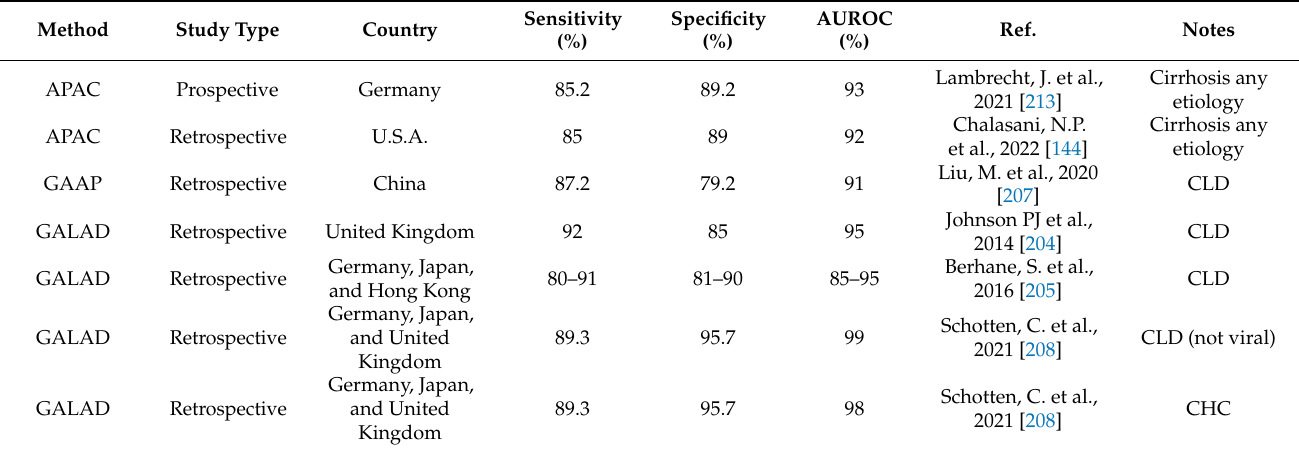
Table 3. Example of candidate HCC diagnostic/prognostic algorithms. Sensitivity, specificity and AUROC shown as percentages